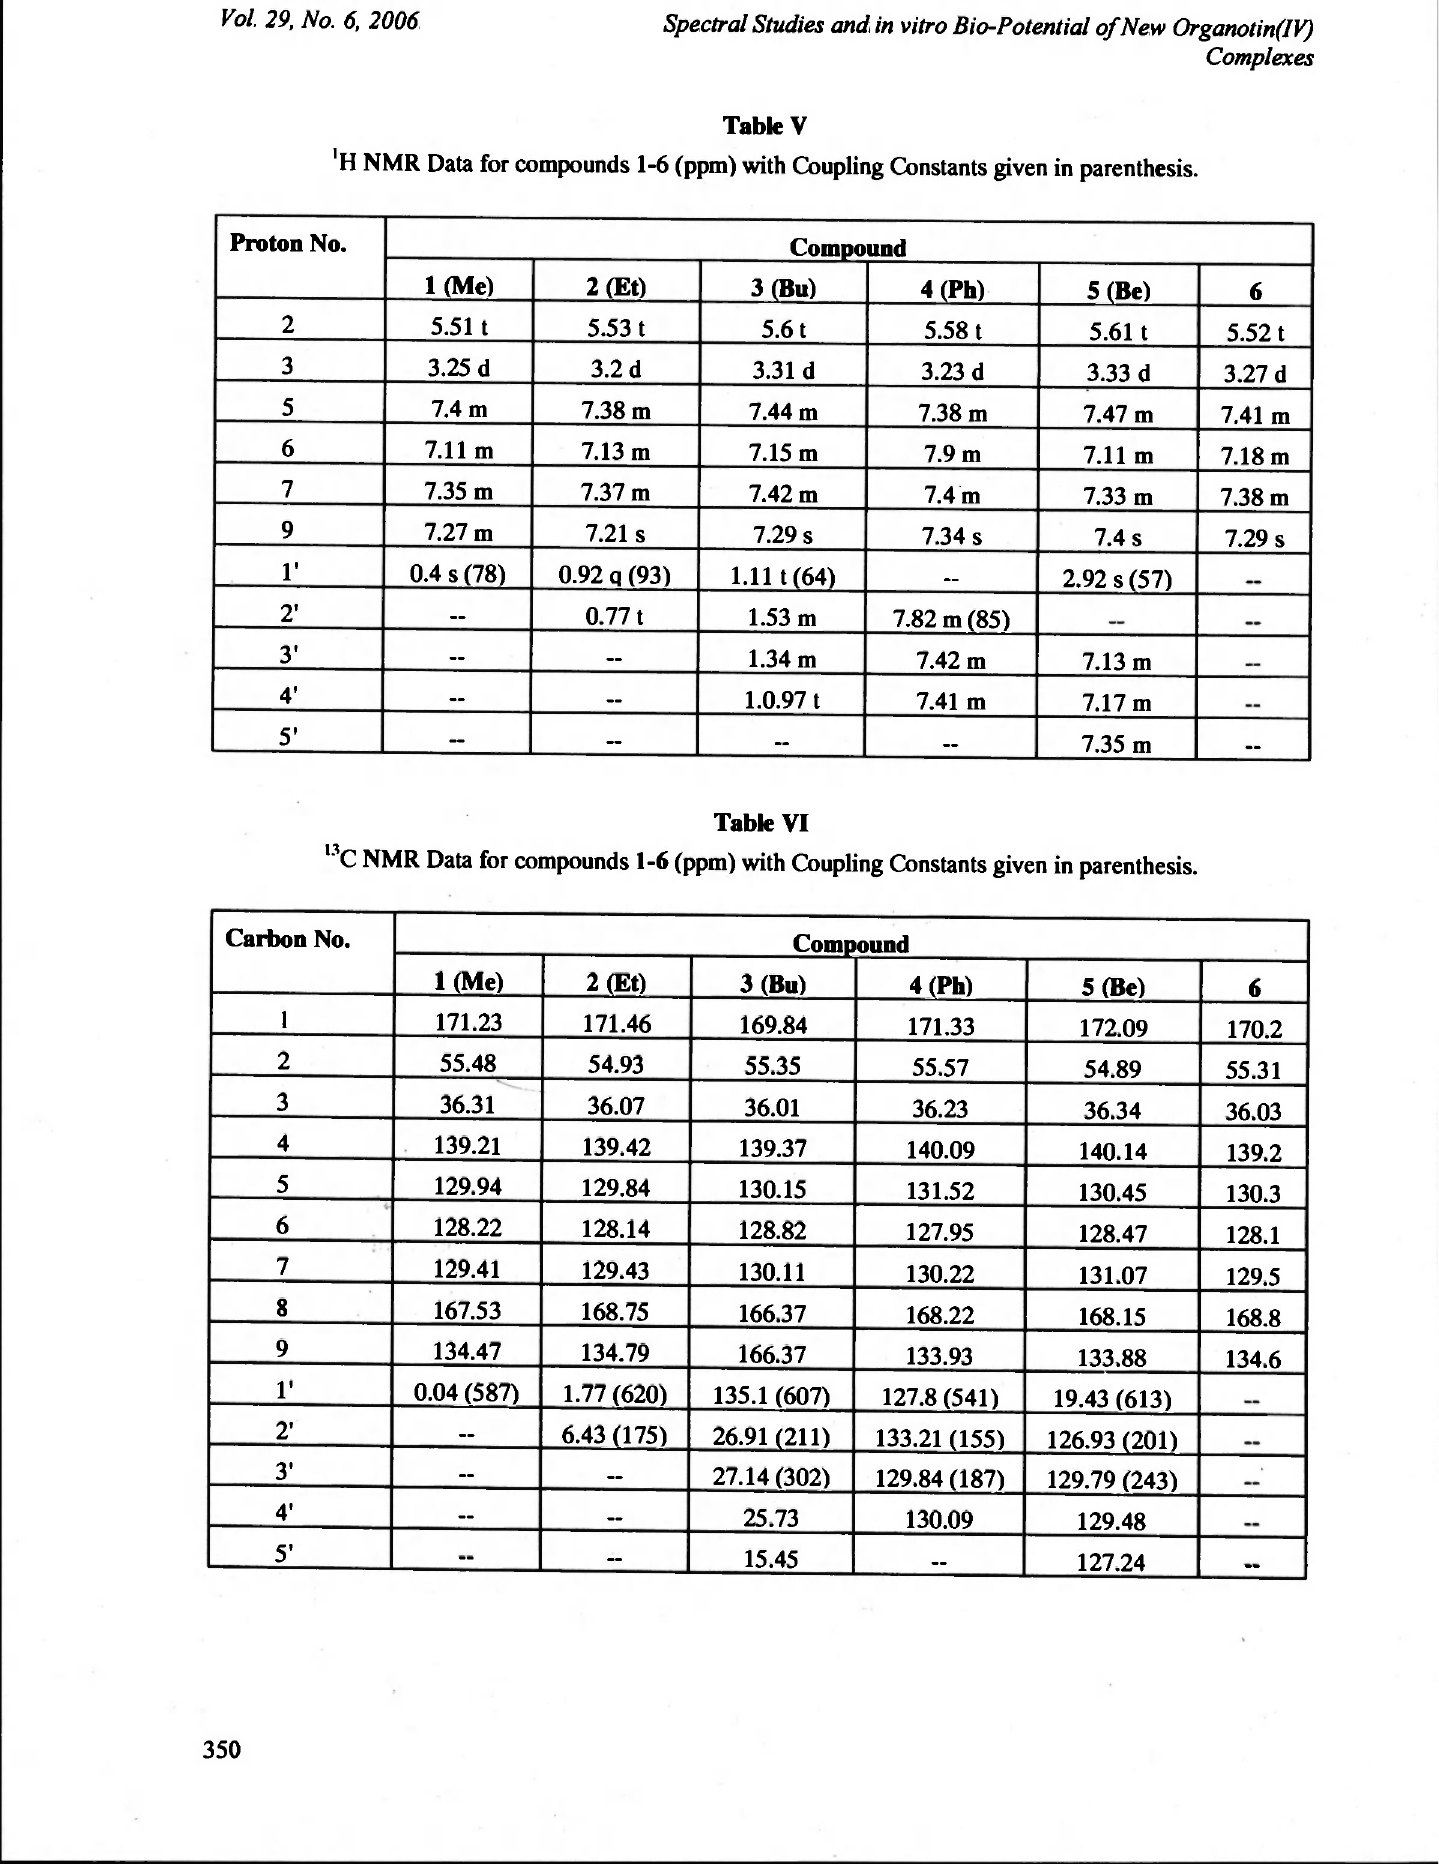
"C NMR Data for compounds 1-6 (ppm) with Coupling Constants given in parenthesis. Carbon No. Compound Carbon